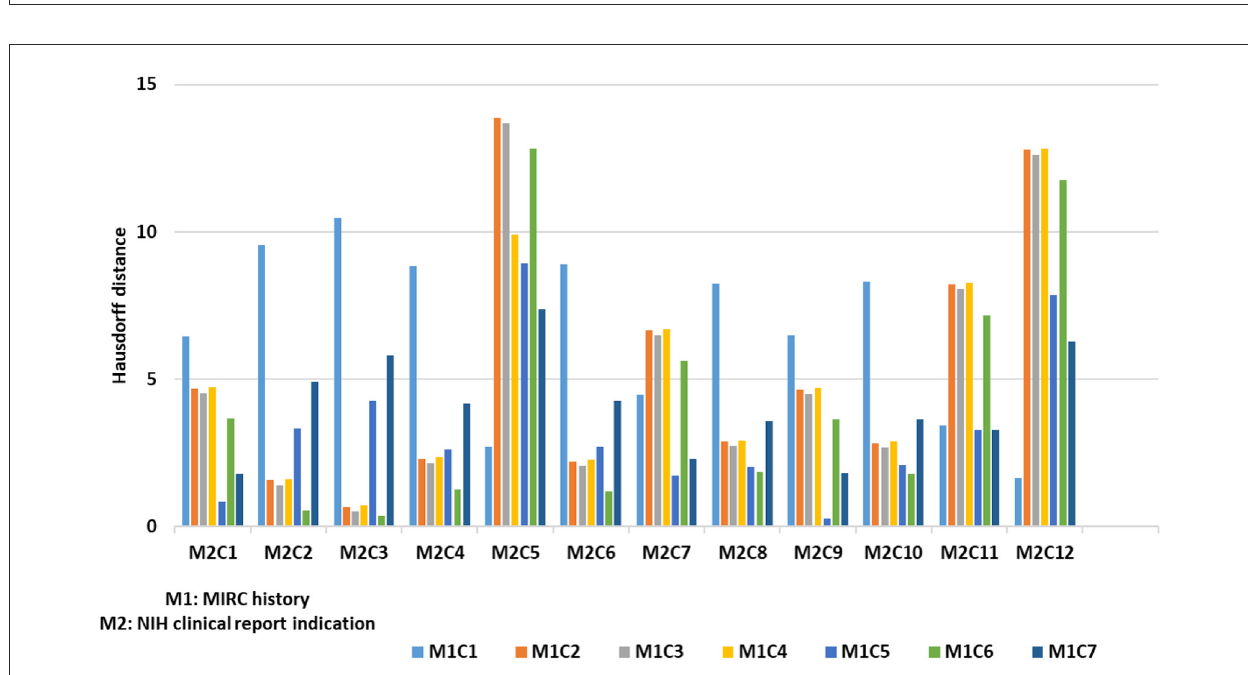
FIGURE7 Example of Hausdorff distance between sub-categories